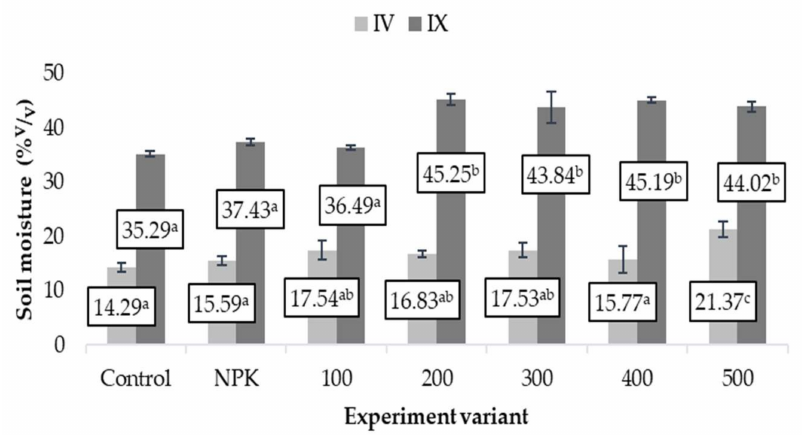
Figure 5. Changes in the moisture of the podzolic soil in IV (April) and IX (September) 2021 in the 0–5 cm layer after the application of biomass combustion ashes (mean ± SD). Treatments not sharing the same letter(s) are statistically significant at p < 0.05 (Tukey’s HSD).